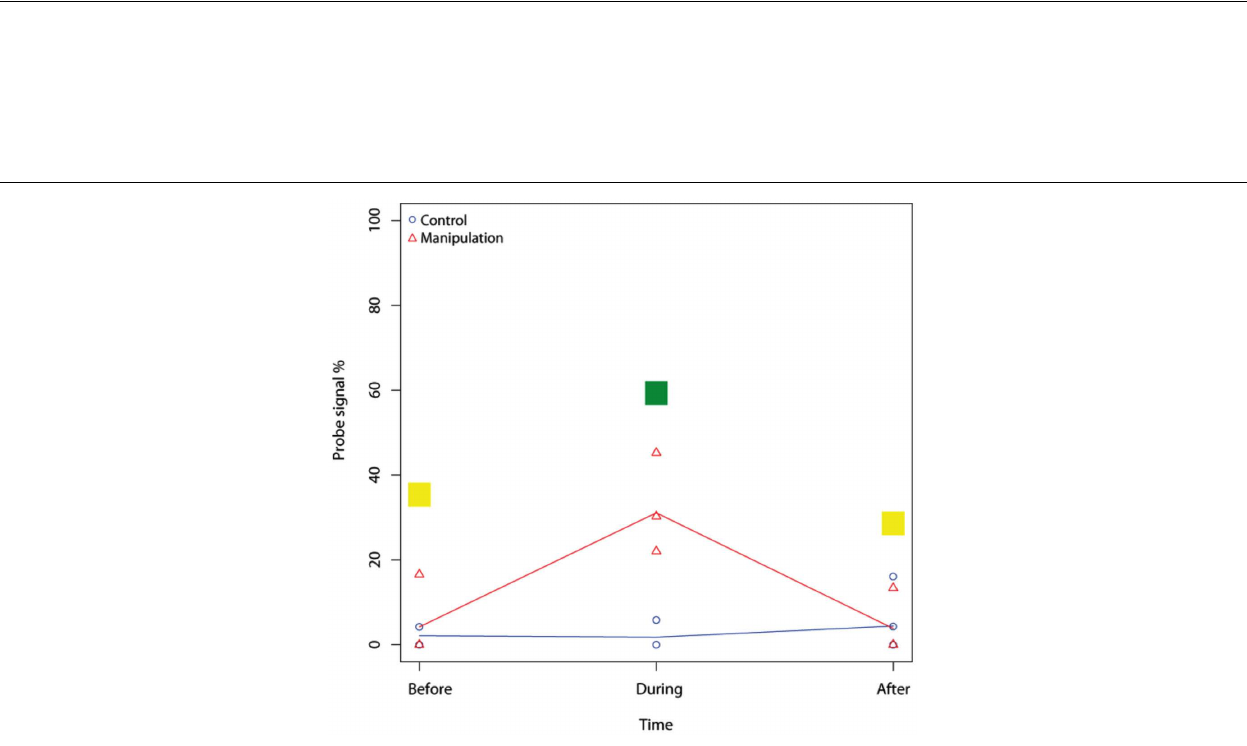
FIGUREA4 |The water table in the study plots. The water table was measured from perforated plastic tubes inserted in soil inside the study plots.The ratio of mean water level of nitrogen loaded and control plots is marked on bottom of the figure.